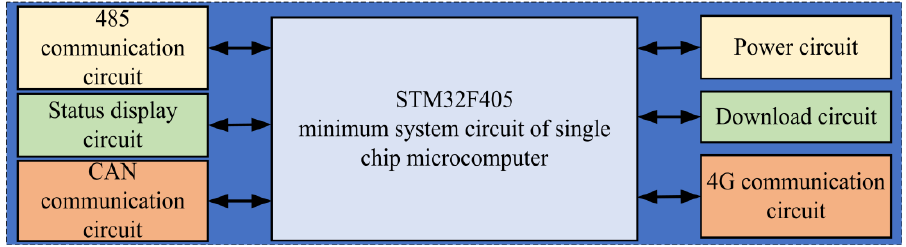
Figure 6. Hardware system block diagram.